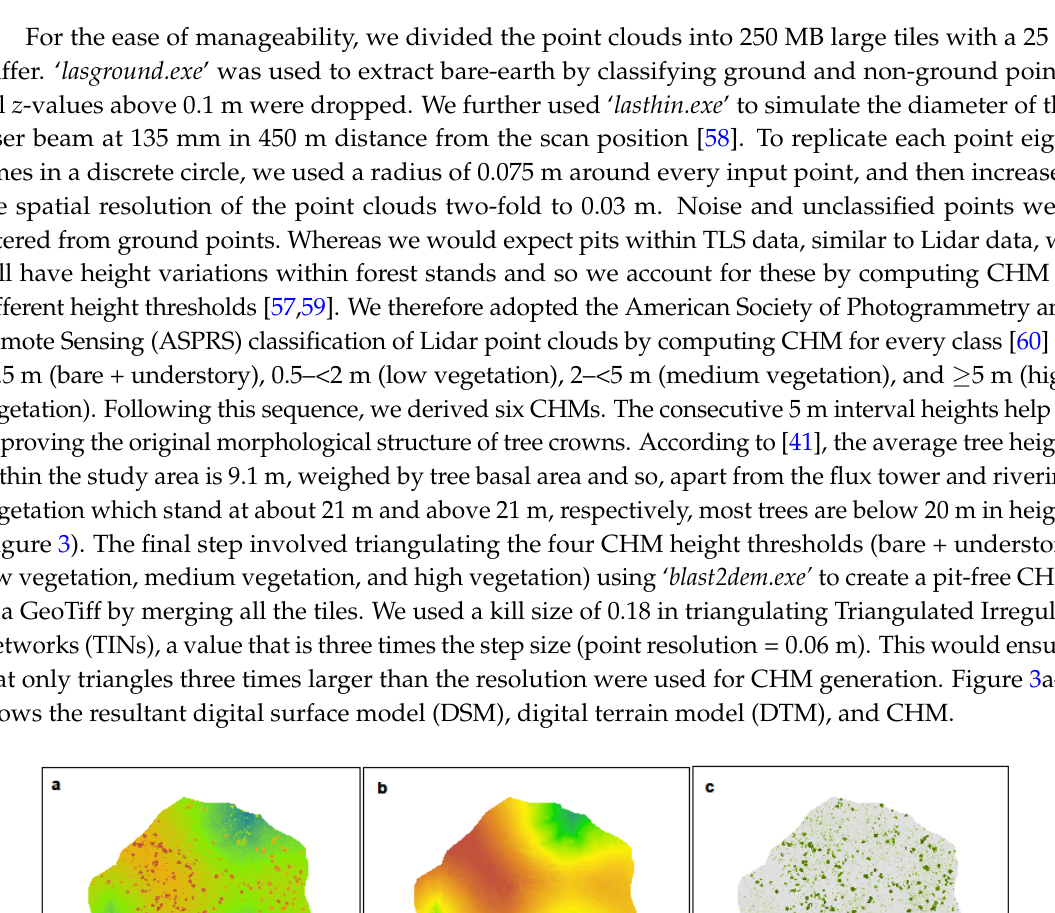
Table 1. Riegl VZ ‐ 1000 specification (source: Riegl, 2015 [54]).